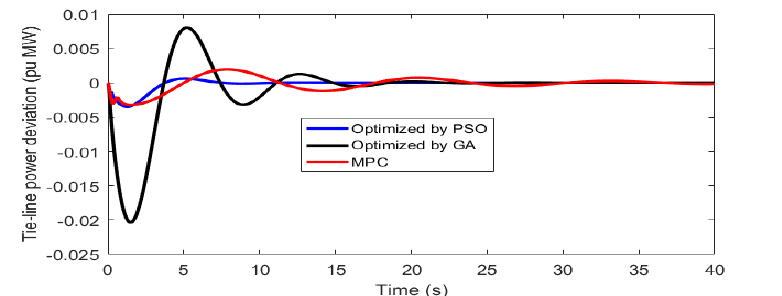
Figure 15. Tie-line power deviation for the third case.